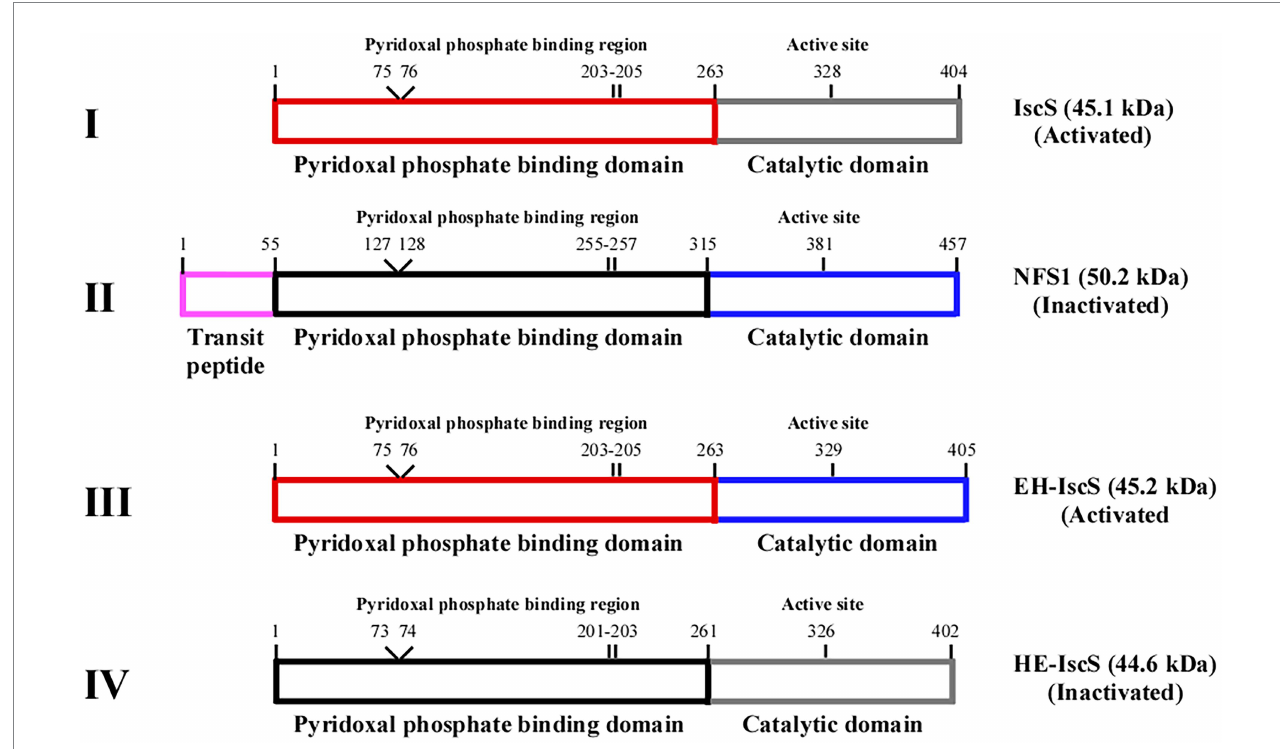
FIGURE 2 Schematic illustration of the chimeric CDs construction strategy based on Escherichia coli IscS and human NFS1. (I) IscS, (II) NFS1, (III) chimeric CD EH-IscS, (IV) chimeric CD HE-IscS. Frames of the same colour represent the same